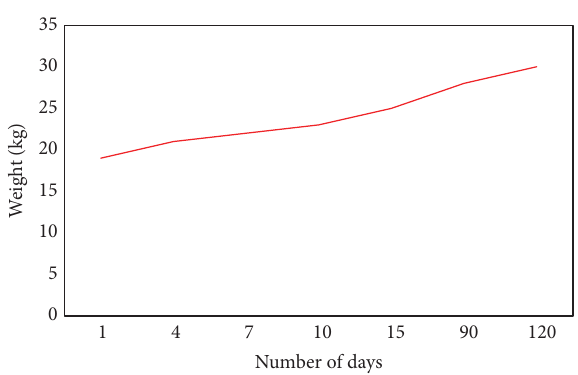
Figure 1: A diagram showing the increase in body weight with time.